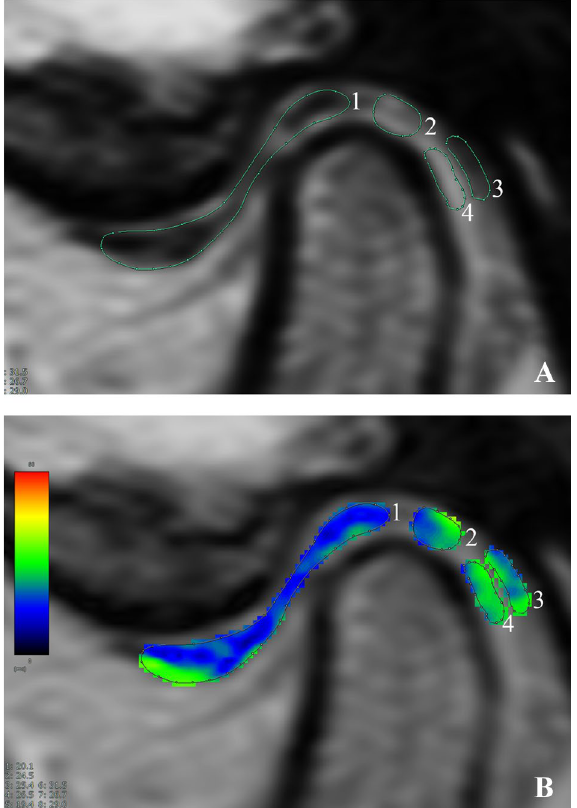
Figure 3. MR parasagittal images of the temporomandibular joint in closed-mouth position at 3.0 T, used for T2 relaxation time measurement. ( A ) ROI selection for the articular disc (1), bilaminar zone (2), superior and inferior lamina (3, 4). ( B ) The T2 relaxation times of ROIs integrated with a color-coded map displaying values from 0 (dark blue) to 60 (red)